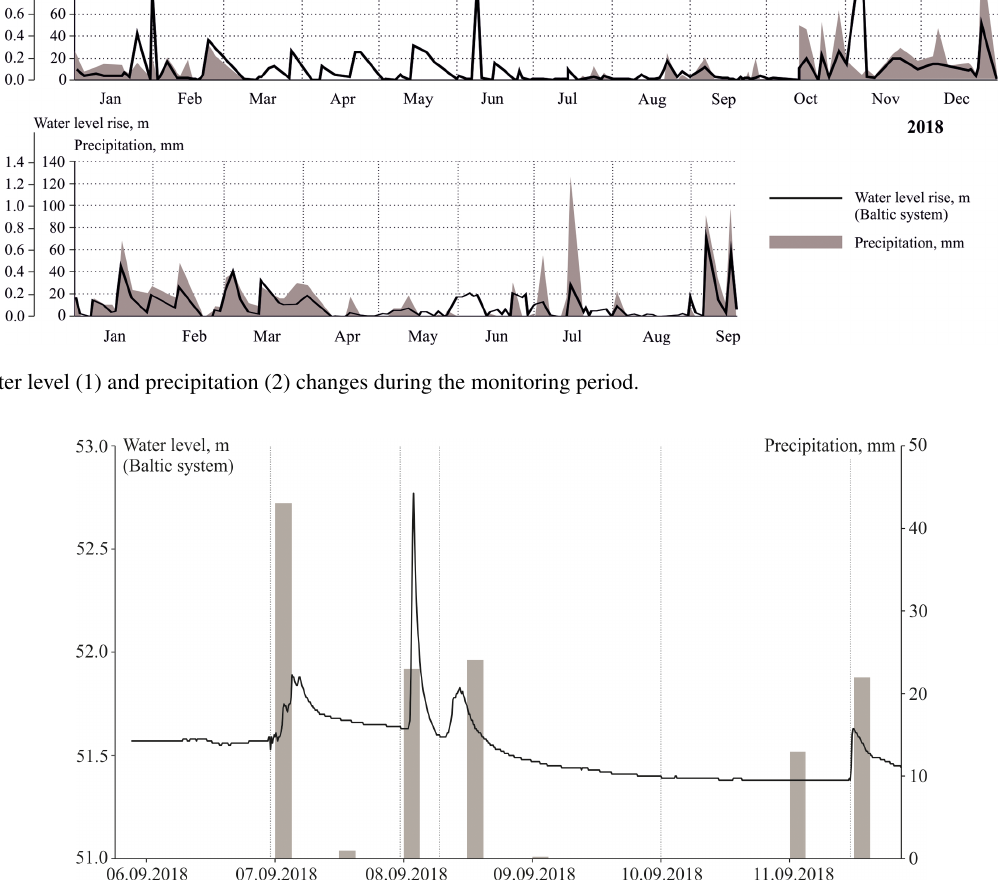
Figure 6. Hydrological events and rainfall in September